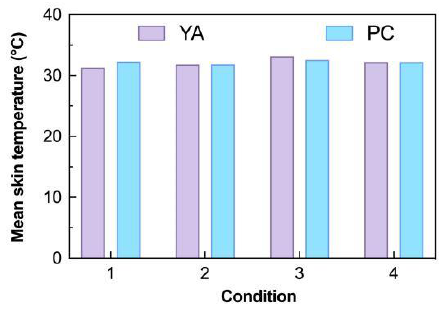
Figure 6. Mean skin temperature of two groups of participants.